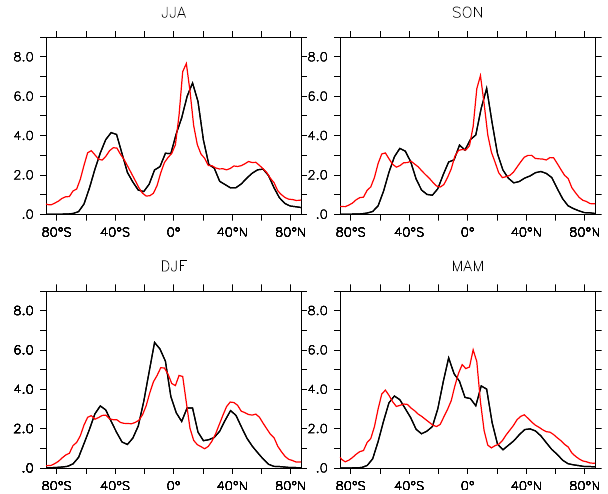
Fig. 15. Seasonal zonal average of climatological precipitation rate (in mmday − 1 ). The red lines show observations from the Global Precipitation Climatology Project (1979–2009 climatology), the black lines represent results from the simulation TRANS (1950– 2000